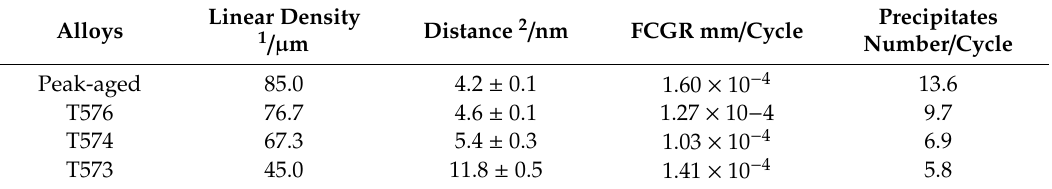
Table 5. Analyses of precipitates contained in per fatigue cycle of peak-aged and over-aged alloys. Alloys